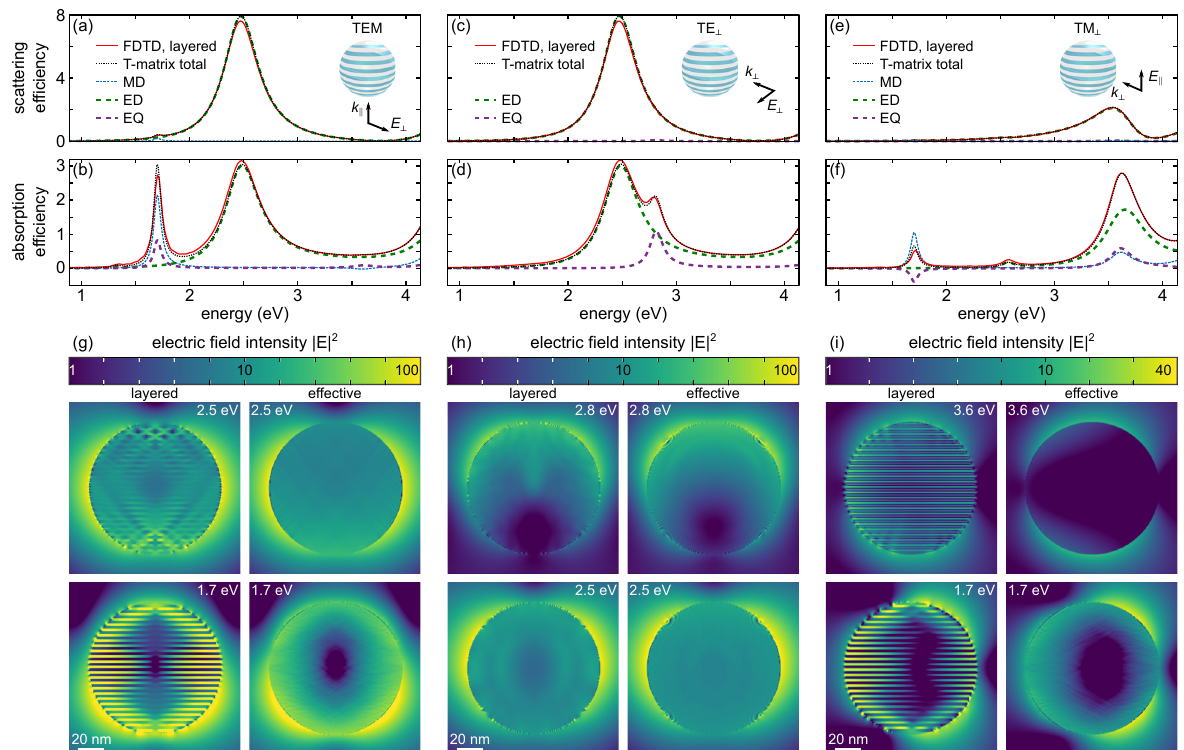
Figure 2: (a–f) Comparison of scattering and absorption of a hyperbolic sphere ( r = 50 nm): the FDTD method with explicit Ag–dielectric = 0 . 5) versus the T -matrix method for an effective permittivity. In the three unique incidence/polarization cases the two multilayers ( f m methods agree quantitatively. Here, three multipoles are active: the ED, MD, and EQ, and appear at various energies depending on illumination. For example, for E ∥ a strong ED appears at 2.5 eV, but is also present above 3.5 eV and is mixed with the MD and EQ. The MD is excited only for k ⊥ , E ∥ and k ∥ , E ⊥ but is, respectively, intermixed with the EQ in- or out-of-phase. This mixing creates a unique resonance which is very strongly absorptive and has minute scattering. (g–i) Comparison of electric field cross sections from FDTD and T -matrix calculations at selected resonances further demonstrates good agreement between the two approaches, validating the use of an anisotropic effective